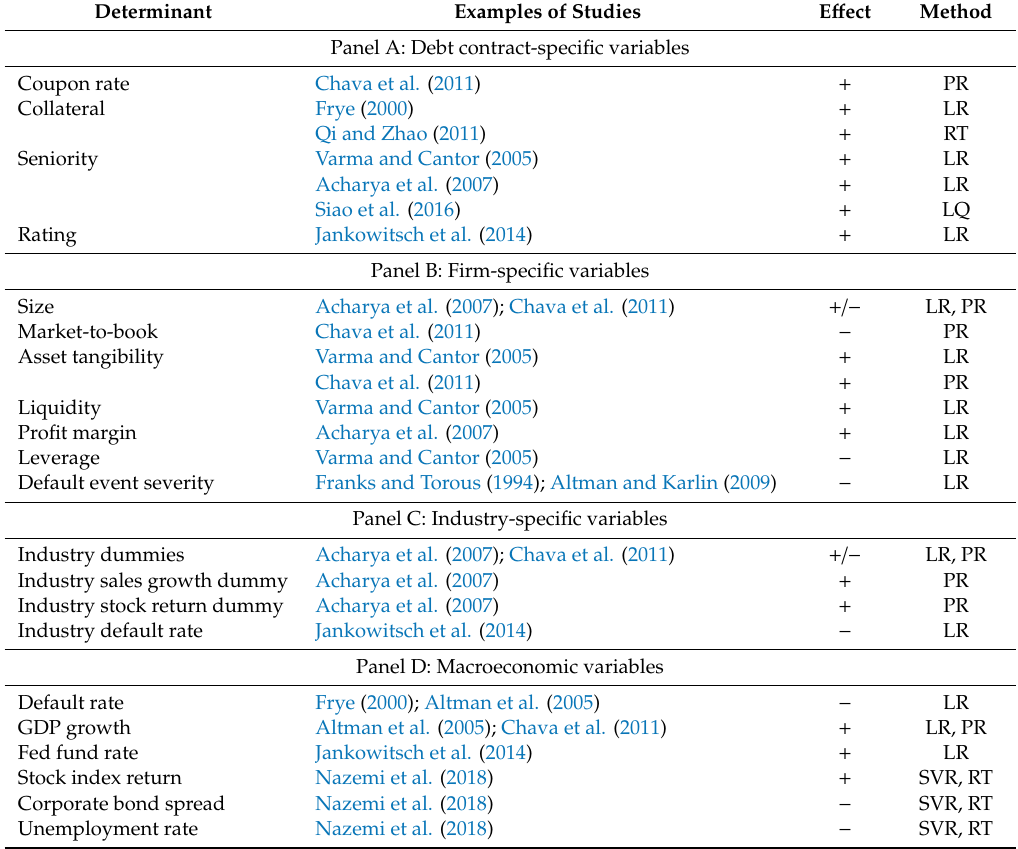
Table 1. Review of the determinants of historical recovery rates. For each identified determinant, the table lists some studies documenting a significant relation with historical recovery rates. The next columnindicateswhetherthatrelationispositiveornegative. Themethodreferstolinearregression(LR), probit regression (PR), logistic quantile regression (LQ), support vector regression (SVR), or regression trees